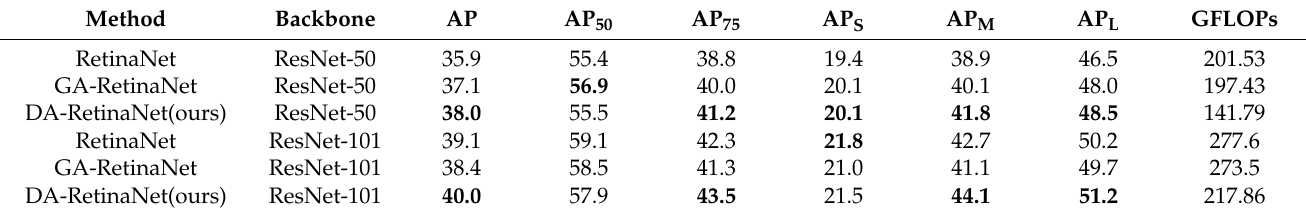
Table 4. The compared results on MS COCO 2017 test-dev. We used AP, AP 50 , AP 75 , AP S , AP M , AP L to evaluate the performance of the three models and counted the floating-point computation (GFLOPs) of all